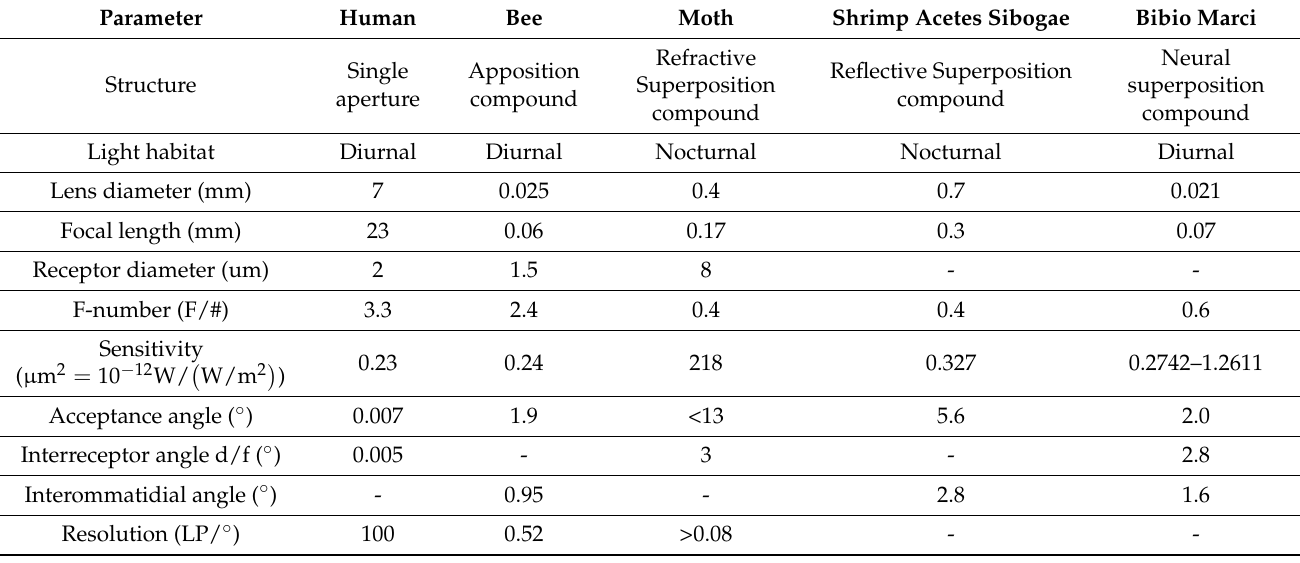
Table 1. A comparison of the single-aperture, the apposition, and the superposition eye [24,25]. Parameter Human Bee Moth Shrimp Acetes Sibogae Bibio Marci Neural Reflective Superposition Apposition Superposition compound compound compound